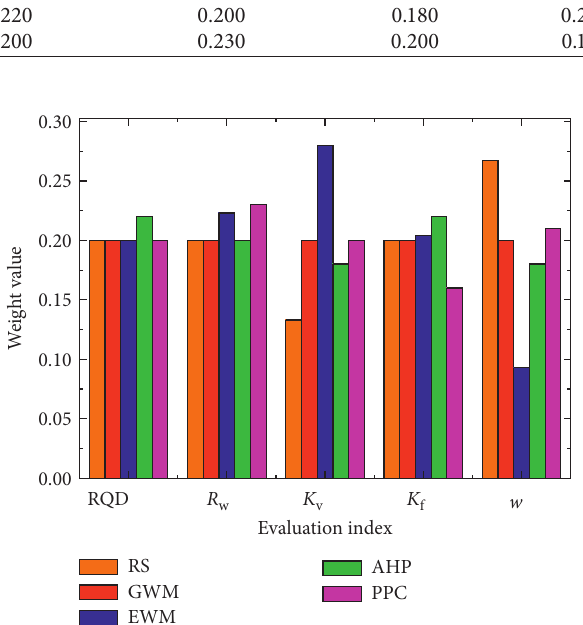
Figure 5: Distribution of index